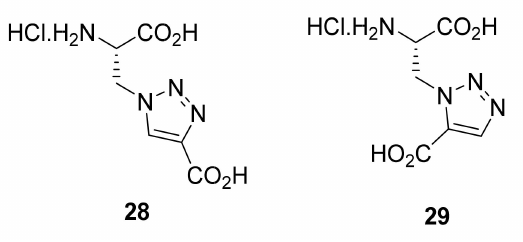
Figure 11. Two selective AMPA receptor ligands exhibiting competitive binding.